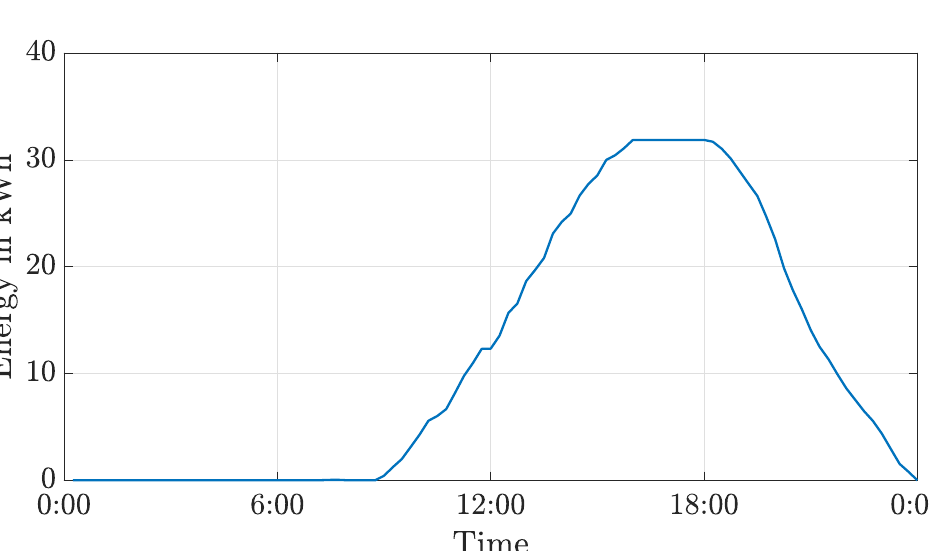
Figure 11. Total power import per phase.